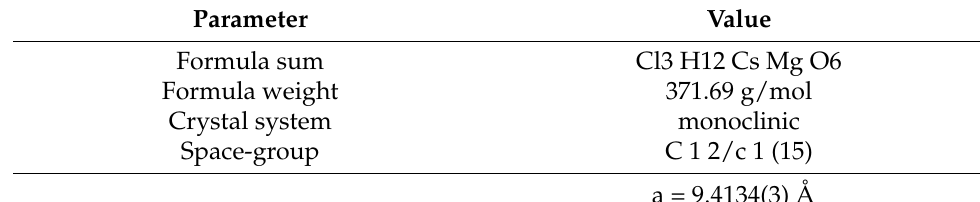
Table A4. X-ray diffraction parameters of double salt MgCl